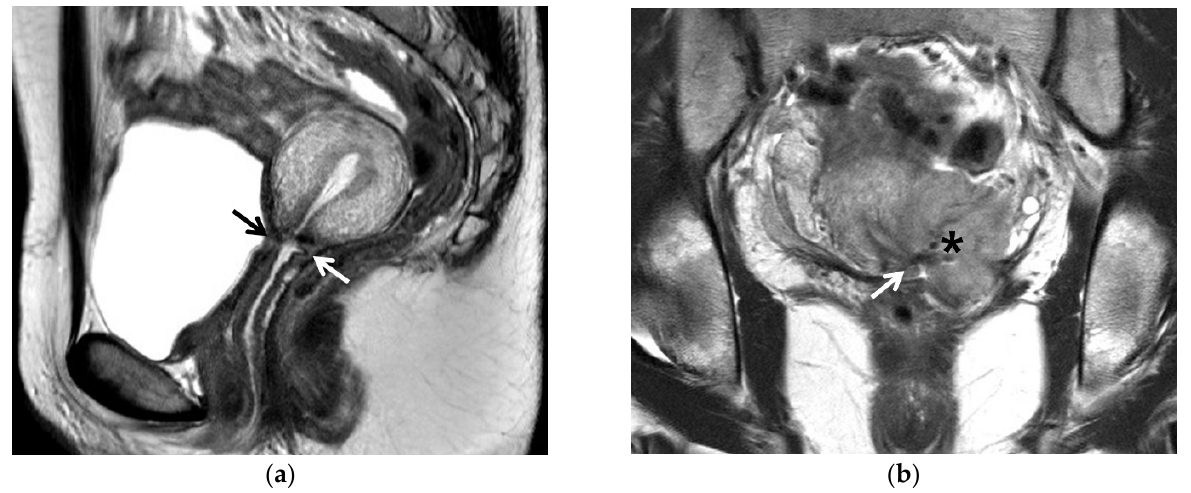
Figure 3. A 30-year-old woman with IB1 cervical cancer: ( a ) T2-weighted sagittal image showed no residual tumor at the trachelectomy site (arrows) in which the uterine body was anastomosed with the vagina. ( b ) T2-weighted coronal image obtained 5 months after trachelectomy showed a recurrent tumor (asterisk) at the left-side margin of the trachelectomy (arrow).